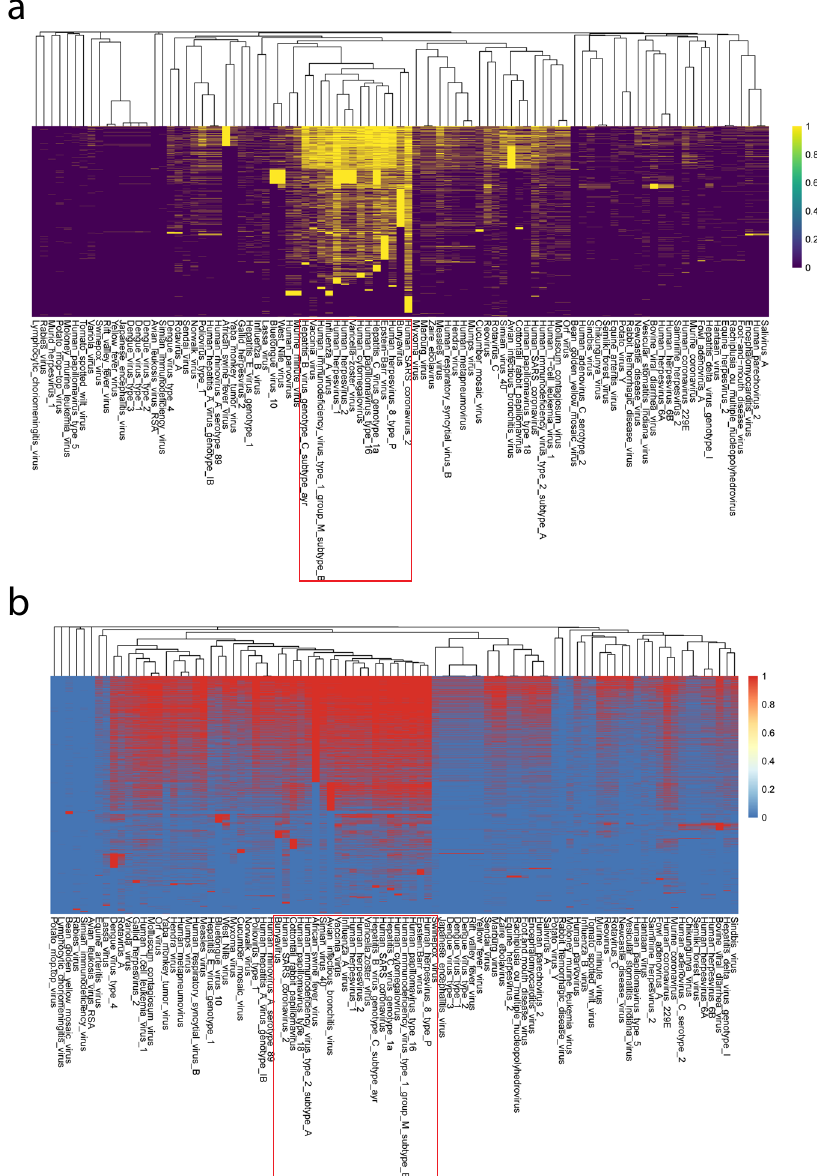
Fig. 6 Clustering analysis based on the viruses ’ fi rst and second-range human protein targets and their related Gene Ontology biological processes. Viruses are clustered based on their ( a ) shared human protein targets including direct and secondary interactors and ( b ) the enriched biological processes (Gene Ontology) containing these direct and secondary targets. Binary distance has been used to perform the hierarchical clustering in all subplots. Red boxes highlight the cluster containing SARS-CoV-2. Enrichment analyses were performed with the R package clusterPro fi ler 50 with a cutoff of p value <0.005. Viruses for which we could not fi nd any enriched GO biological process do not appear on the enrichment heatmaps. Complete results of these enrichment analyses are available as Supplementary Data 3 and